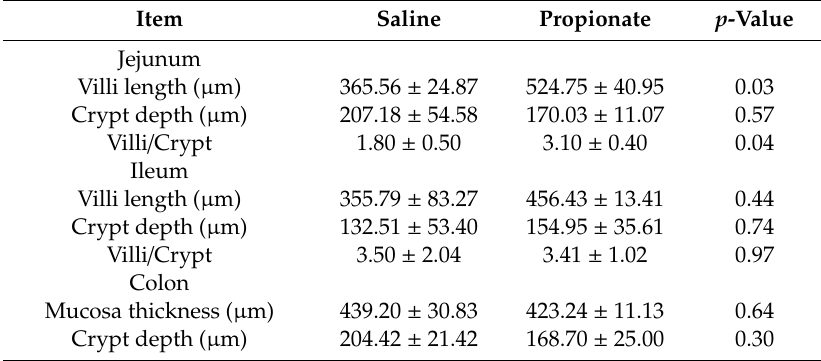
Table 4. E ff ects of the cecal infusion of sodium propionate on the intestinal morphology.